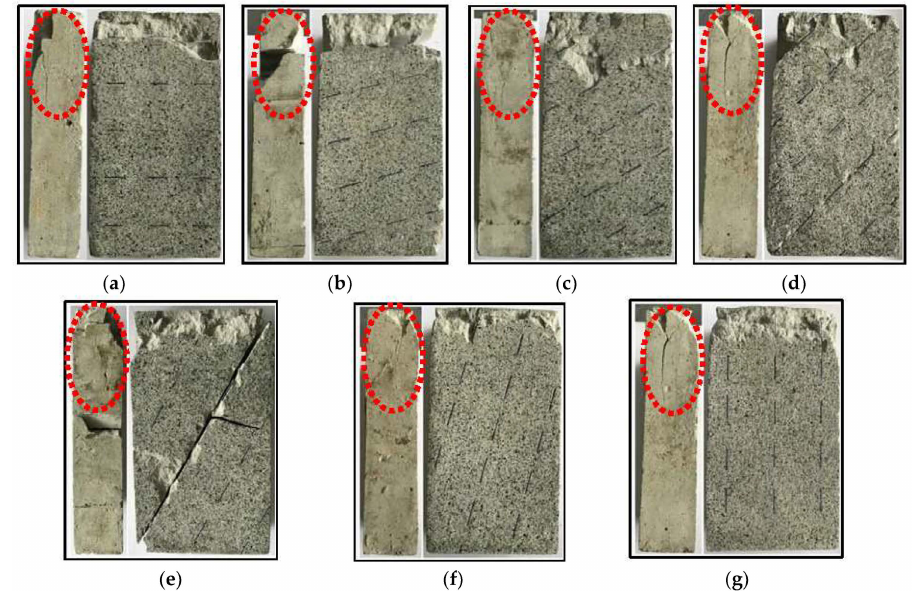
Figure 10. Failure modes of specimens with different dip angles under biaxial compression. ( a ) α = 0 ◦ ; ( b ) α = 15 ◦ ; ( c ) α = 30 ◦ ; ( d ) α = 45 ◦ ; ( e ) α = 60 ◦ ; ( f ) α = 75 ◦ ; ( g ) α = 90 ◦